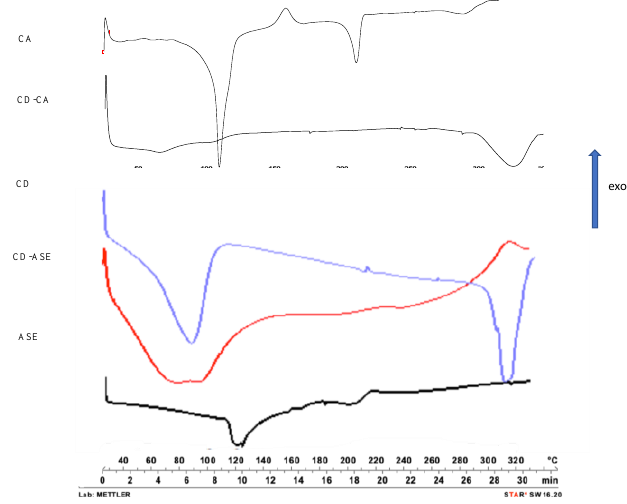
Figure 3. Differential scanning calorimetry of pure materials (ASE, CD, CA), CD-ASE and CD-CA complex.